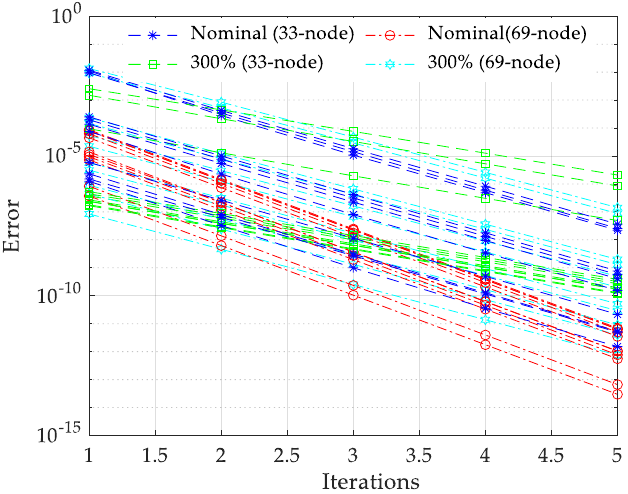
Figure 12. Convergence from the random initial values (33-node, Case 1).